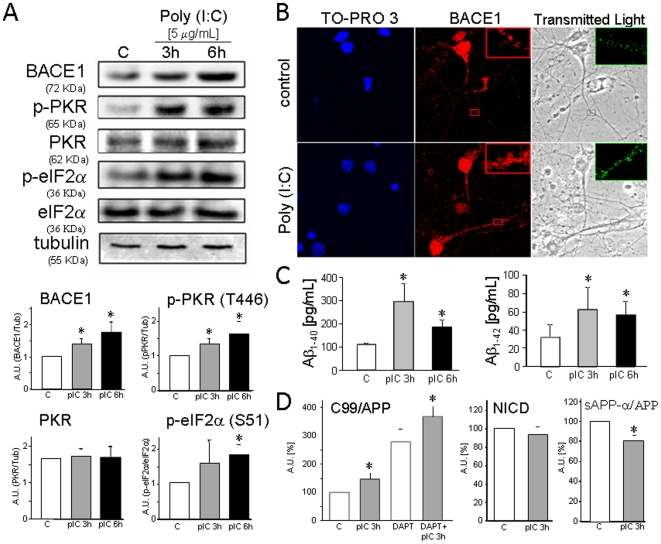
Poly (I∶C) induces PKR activation, upregulates BACE1 and promotes Aß production.The viral dsRNA analog polyinosinic:polycytidylic acid [poly (I∶C)] activates PKR in MEF PERK−/− cells. Protein extracts obtained after 3 and 6 h of poly (I∶C) treatment were analysed by Western blotting using anti-BACE1, anti-phospho-PKR(T446), anti-PKR, anti-p-eIF2-alpha, anti-eIF2-alpha and anti-tubulin Abs. Bands were quantified by densitometric analysis. Results are expressed as the mean ± SEM of 3 independent experiments. * p<0.05 by Student's t test (A). Mature hippocampal neurons were challenged with poly (I∶C) for 3 h and analysed by immunofluorescence to detect BACE1 expression levels (red staining). BACE1 expression in neurites after 6 h of treatment (green staining) is shown in the insets in the transmitted light images (B). Poly (I∶C) triggers Aß1–40 and Aß1–42 production in HEK-APPsw cells. HEK-APPsw cells were challenged with poly (I∶C) at a concentration of 5 µg/mL. Then after 3 h and 6 h the media were collected and Aß1–40 and Aß1–42 levels were determined. Data are mean ± SEM of 5–12 independent experiments. *p<0.05 by Student's t test (C). Study of gamma-secretase activity in HEK-APPsw treated with poly (I∶C) at 3 h. Ratio of C99/total APP, NICD and ratio of sAPP-alpha/total APP were studied in protein extracts analyzed by Western Blotting. Bands were quantified by densitometric analysis. Y axis: arbitrary units. Results are expressed as the mean ± SEM of 3 independent experiments. * p<0.05 by Student's t test (D).